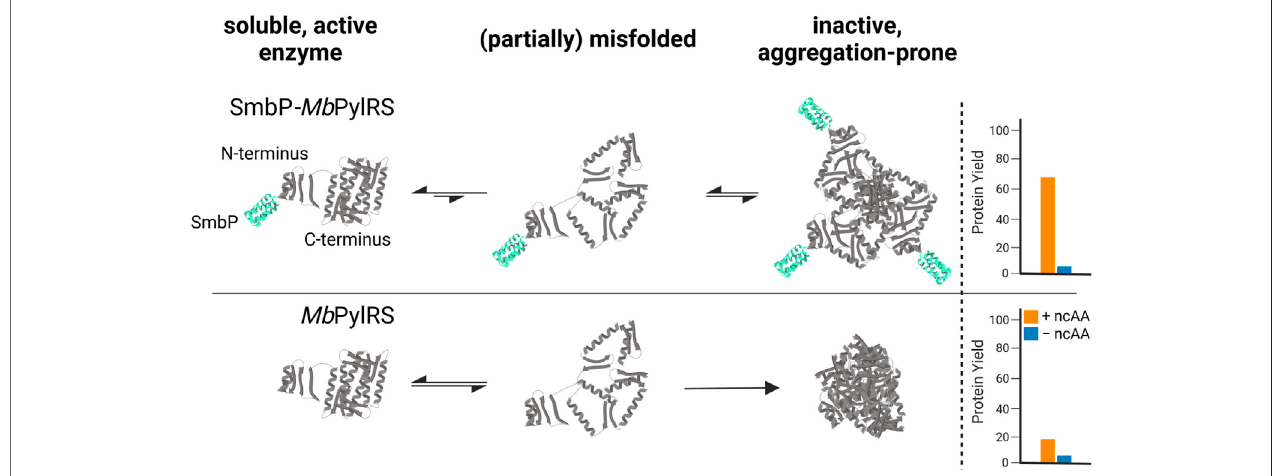
FIGURE1| ProposedmechanismofhowtheSmbP-taghelpstoprovidemorecatalyticallyactive Mb PylRS invivo ,increasingyieldofncAA-modi fi edtargetprotein.